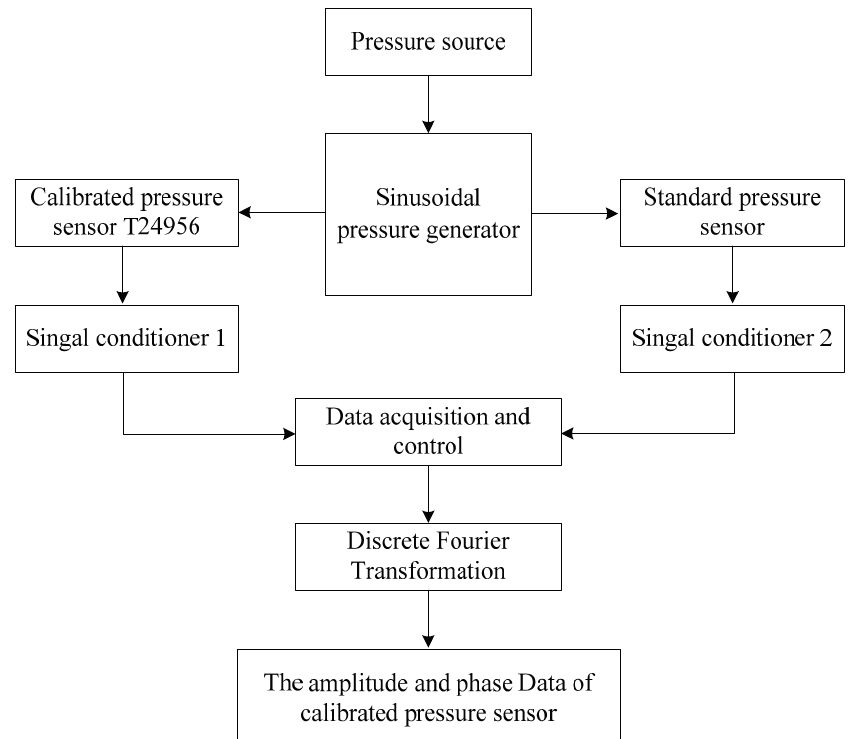
Figure 11. Schematic diagram of the frequency-domain